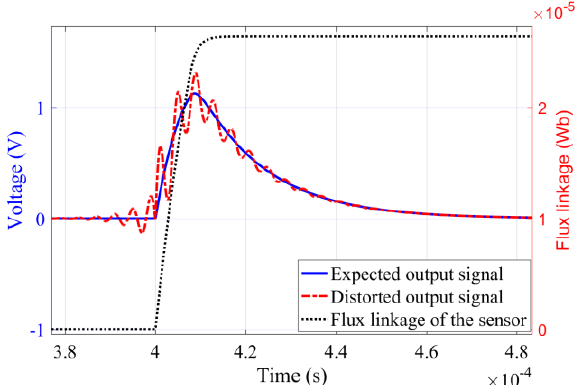
Figure 2. Attenuated oscillation of output signal.